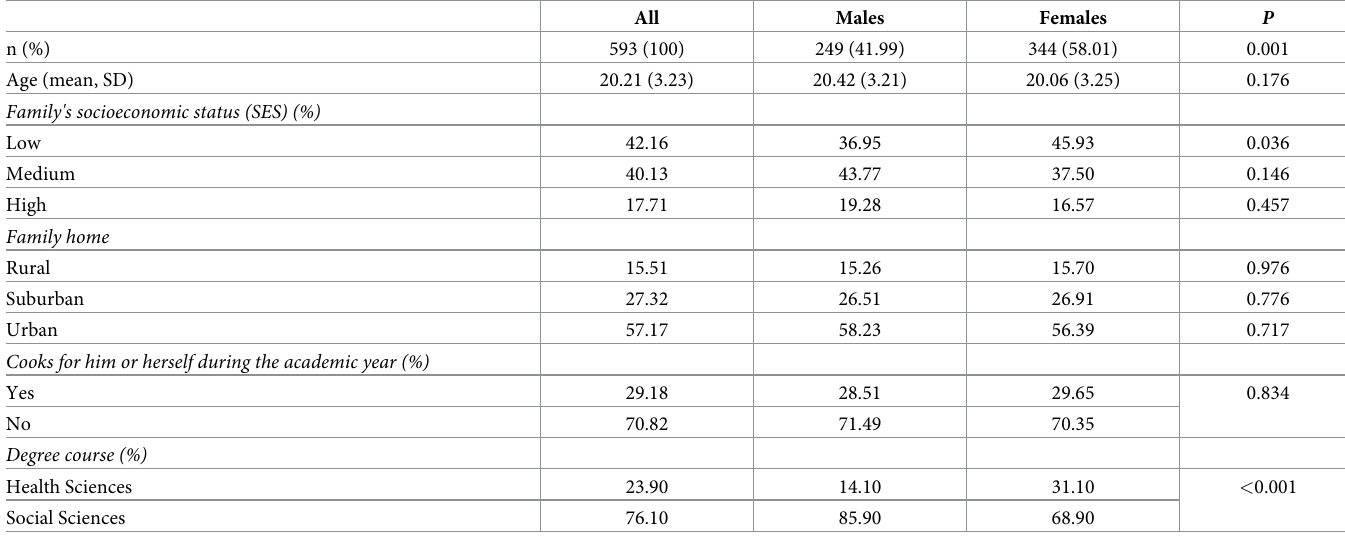
Table 1. Characteristics of the study